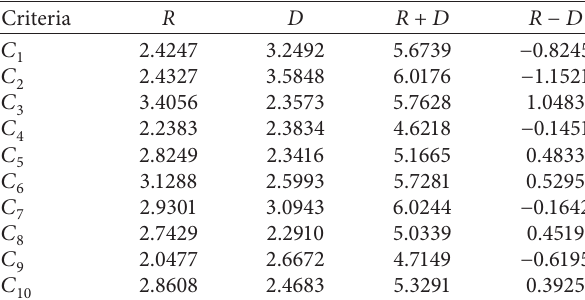
Table 11: R, D , R + D , and R − D for criteria.